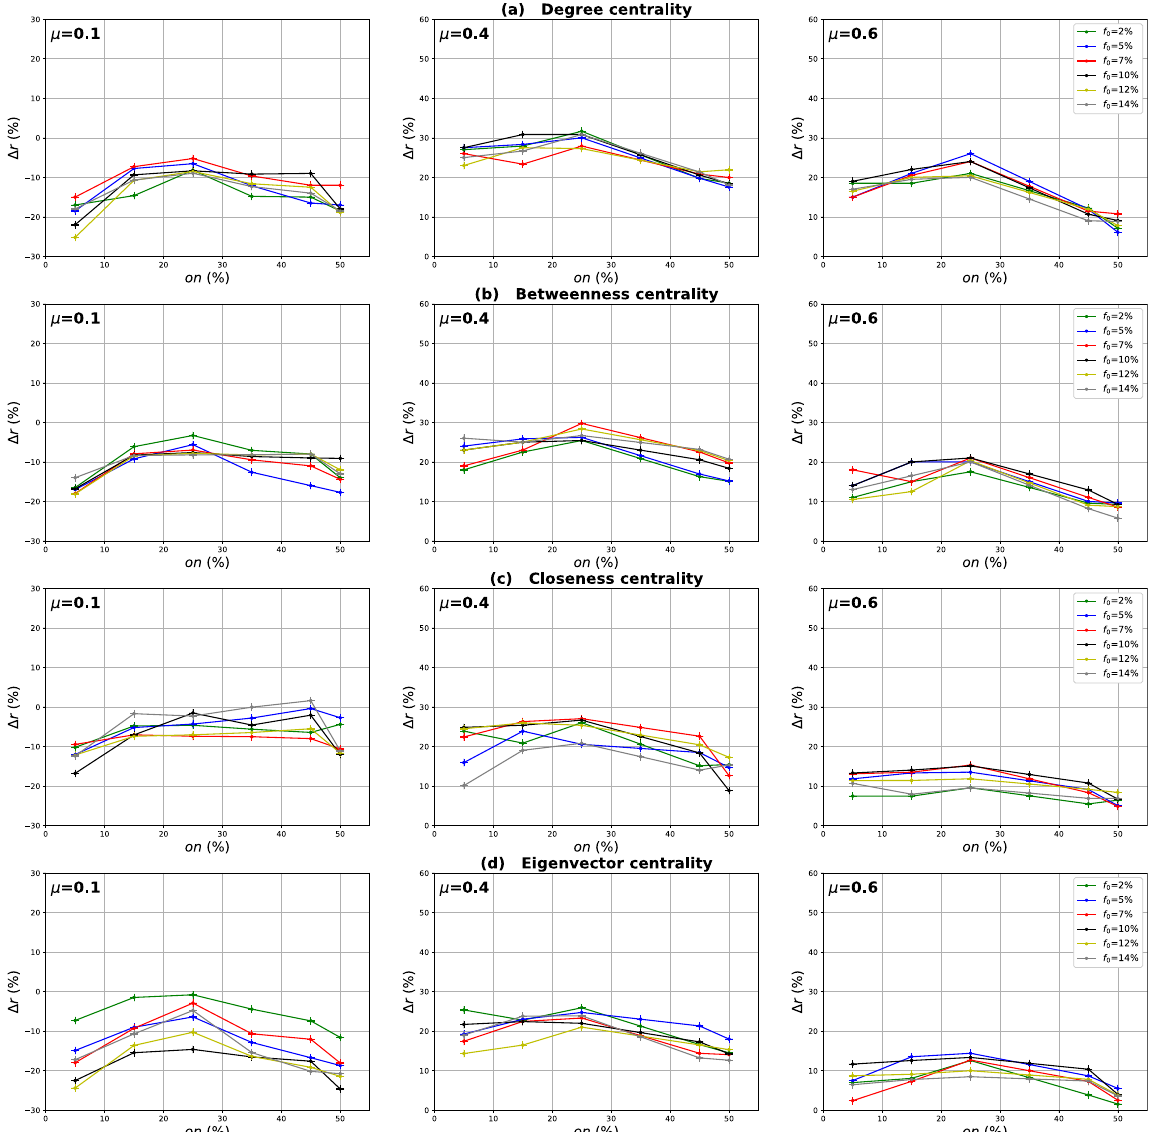
Figure 8. Influence of the number of overlapping nodes. The relative difference of the outbreak size Δ r between the standard measure and the Global measure versus the fraction of the overlapping nodes on . The community membership value om is equal to 10% of the total number of